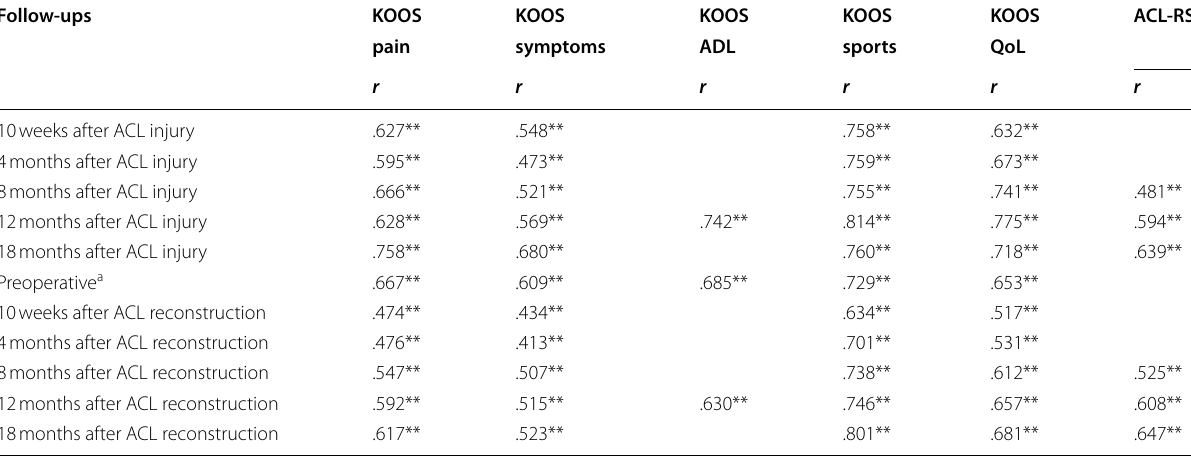
, the KOOS subscales and the ACL-RSI 18